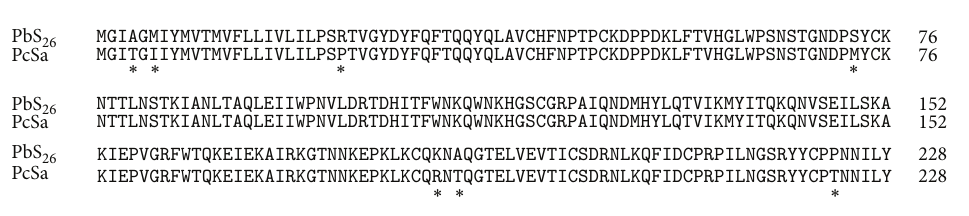
white pear ( P. bretschneideri) , Ussurian pear ( P. ussuriensis